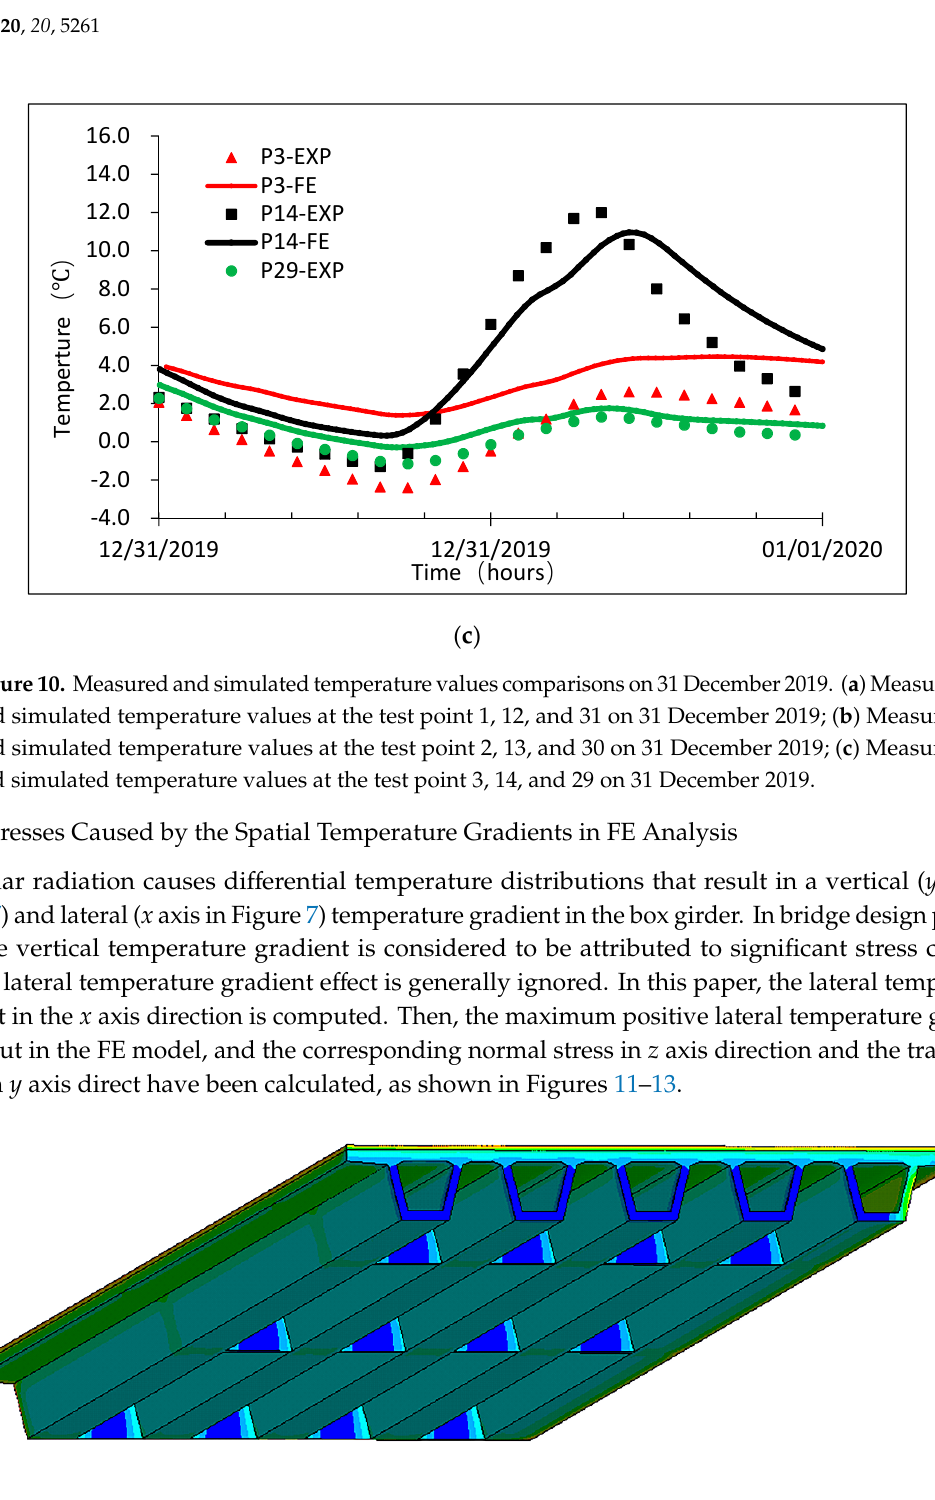
Figure 11. Simulated temperature distribution in the box girder at 15:00 on 31 December 2019 (unit: °C).